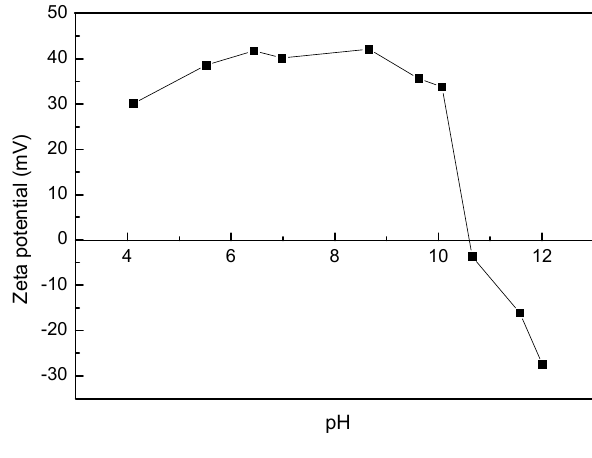
Figure 5. Zeta potentials of 1 wt% polyamine microsphere ultrasonically dispersed in water of different pH.